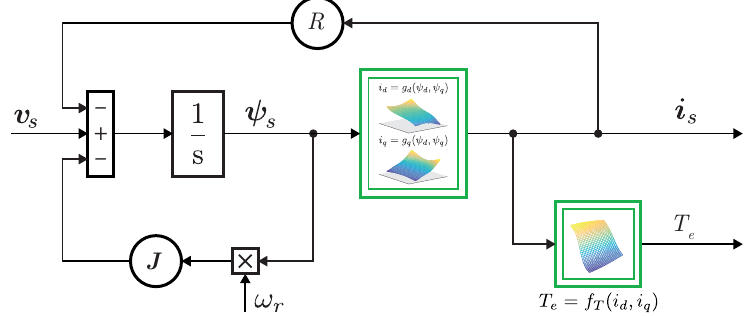
Figure 2. Block diagram of nonlinear flux-linkage model